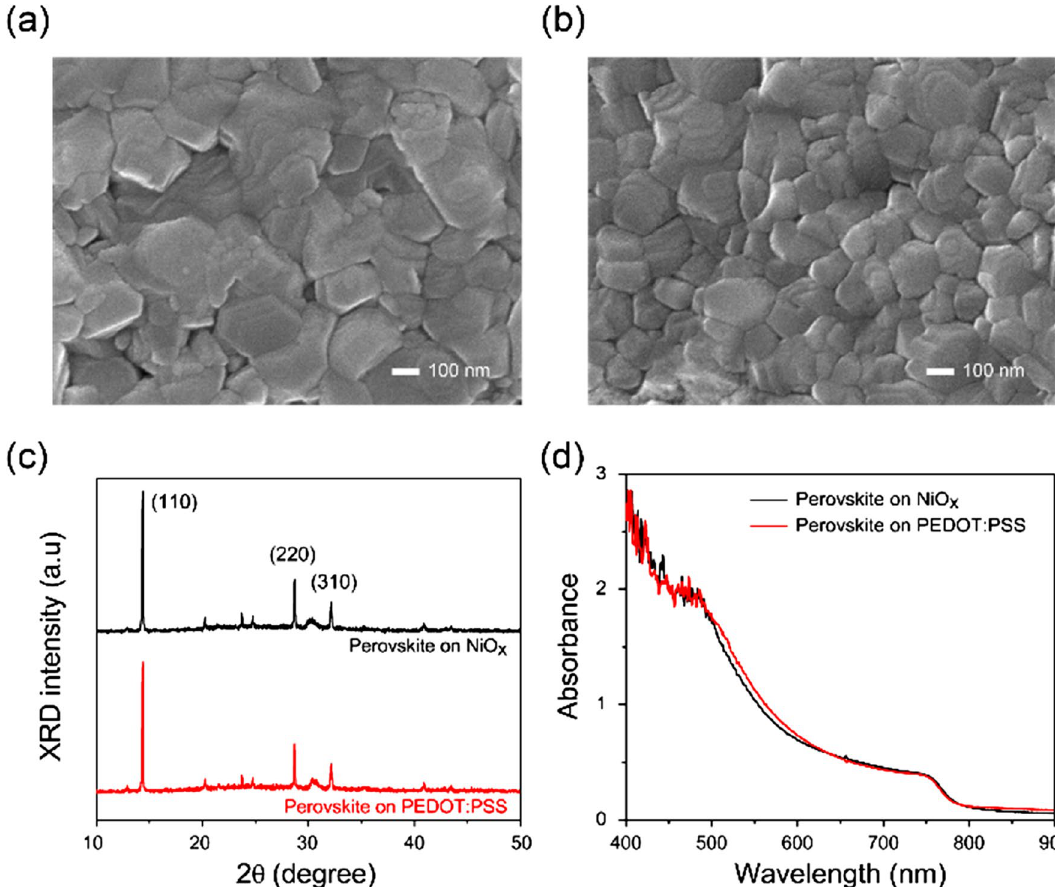
Figure 2. ( a ) SEM image of a perovskite film on the NiO x layer, ( b ) SEM image of a perovskite film on the PEDOT:PSS layer, ( c ) XRD spectra of the perovskite films on the NiO x and PEDOT:PSS HTLs, and ( d ) optical absorbance spectra of the perovskite films on the NiO x and PEDOT:PSS